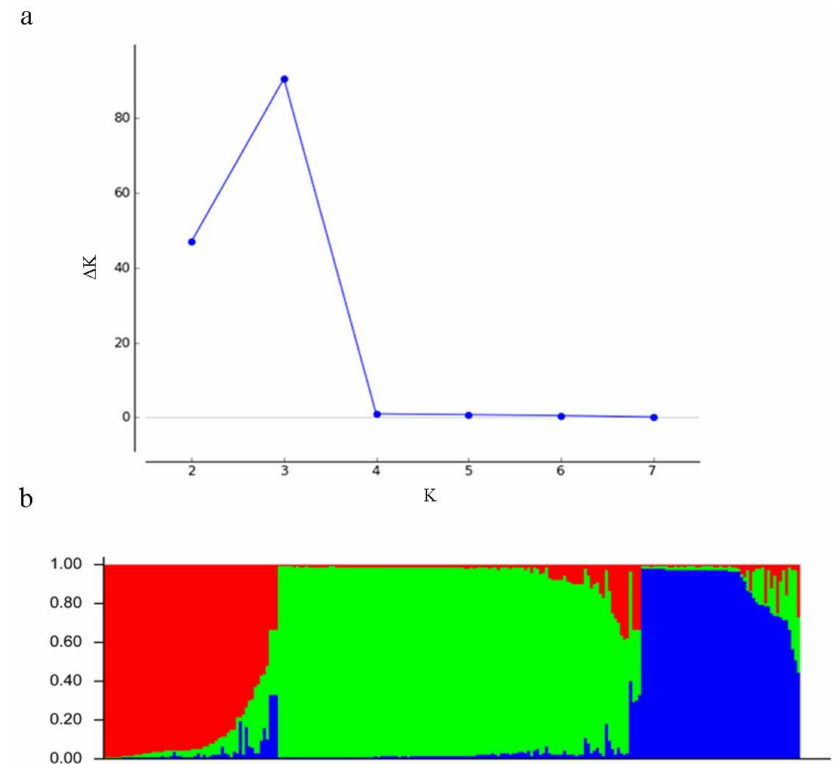
Figure 4. Results of STRUCTURE analysis based on microsatellite data: ( a ) Estimation of population using LnP(D)-derived ∆ K with cluster number (K) ranged from 1 to 8; ( b ) estimated genetic structure of the three populations based on STRUCTURE analysis with K =